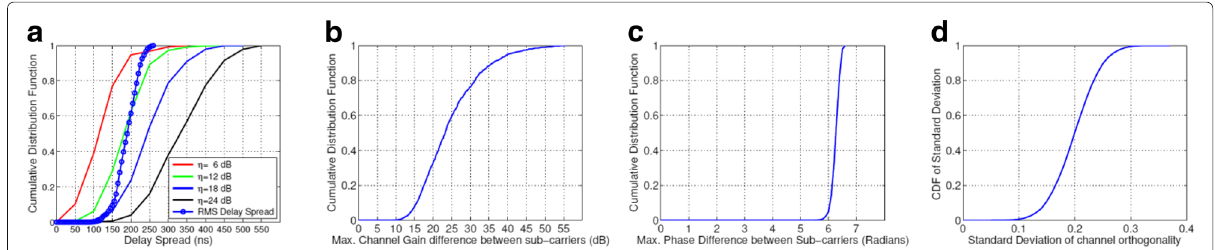
Fig. 2 Verifying impact of frequency selectivity on MU-MIMO performance on 2.4 GHz: a delay spread in an office environment, b maximum channel gain difference across all sub-carriers in an office environment, c maximum channel phase difference across all sub-carriers in an office environment, d channel orthogonality on different sub-carriers between 2